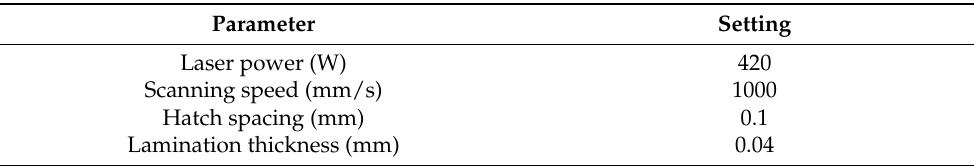
Table 2. Parameters used in the LPBF process.